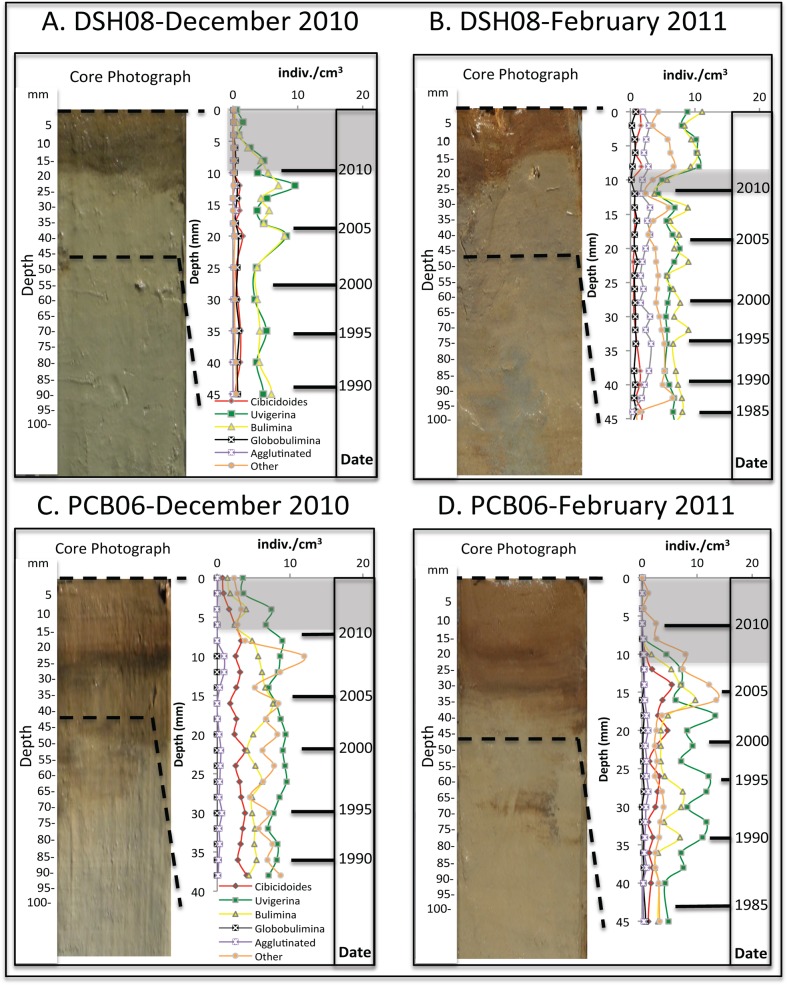
Core photographs and densities (indiv./cm3) of the benthic foraminifera genera throughout the surface sections of each core site including gray areas representing the decline in benthic foraminifera density in each record and the corresponding date.